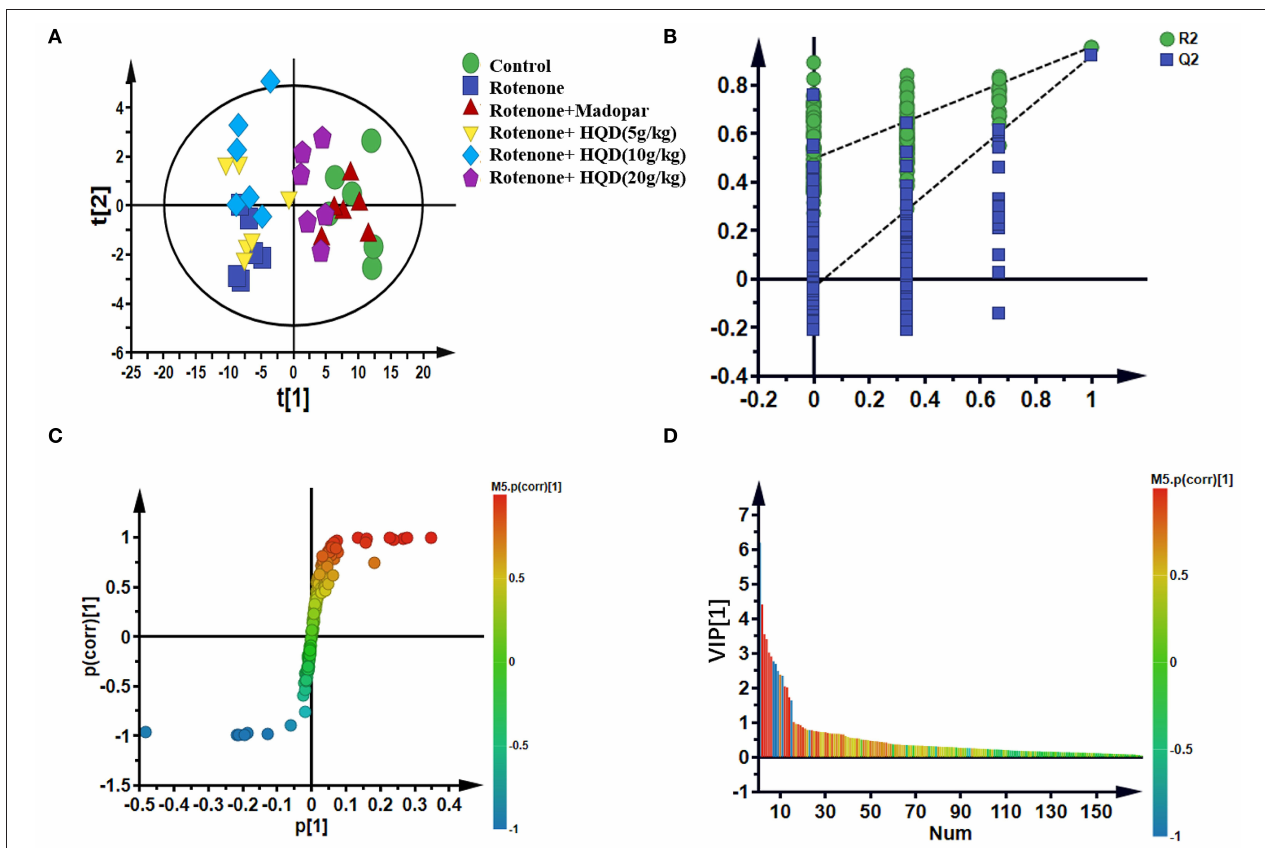
FIGURE 8 | Multivariate statistical analysis of metabolites in mitochondria of midbrain among control group, rotenone group, rotenone + HQD groups, and rotenone + madopar group. (A) PLS-DA score plot. (B) Model validation plot of PLS-DA. (C) S-plot of OPLS-DA. (D) VIP values of OPLS-DA.